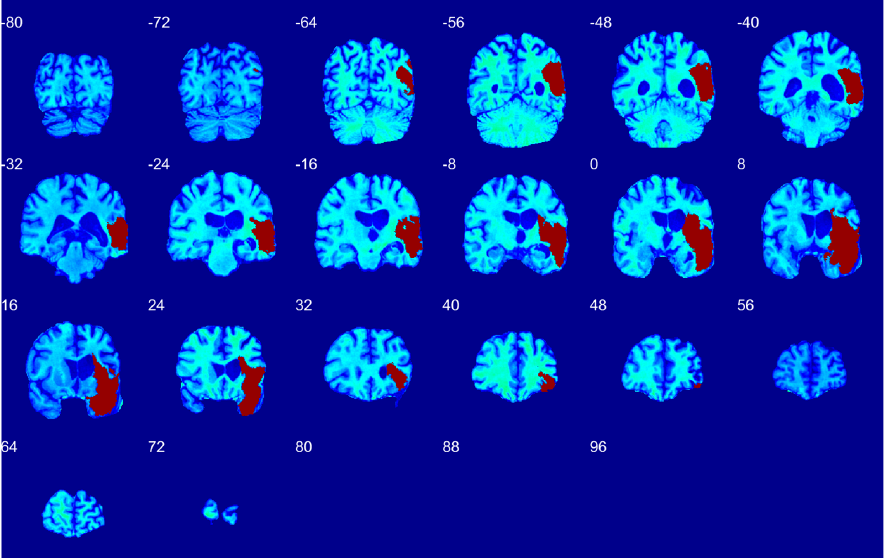
Figure 4. Coronal sections showing automatic segmentation of left MCA stroke as mapped on MNI152 template. The brain slices are sampled at the intervals of 8 mm.